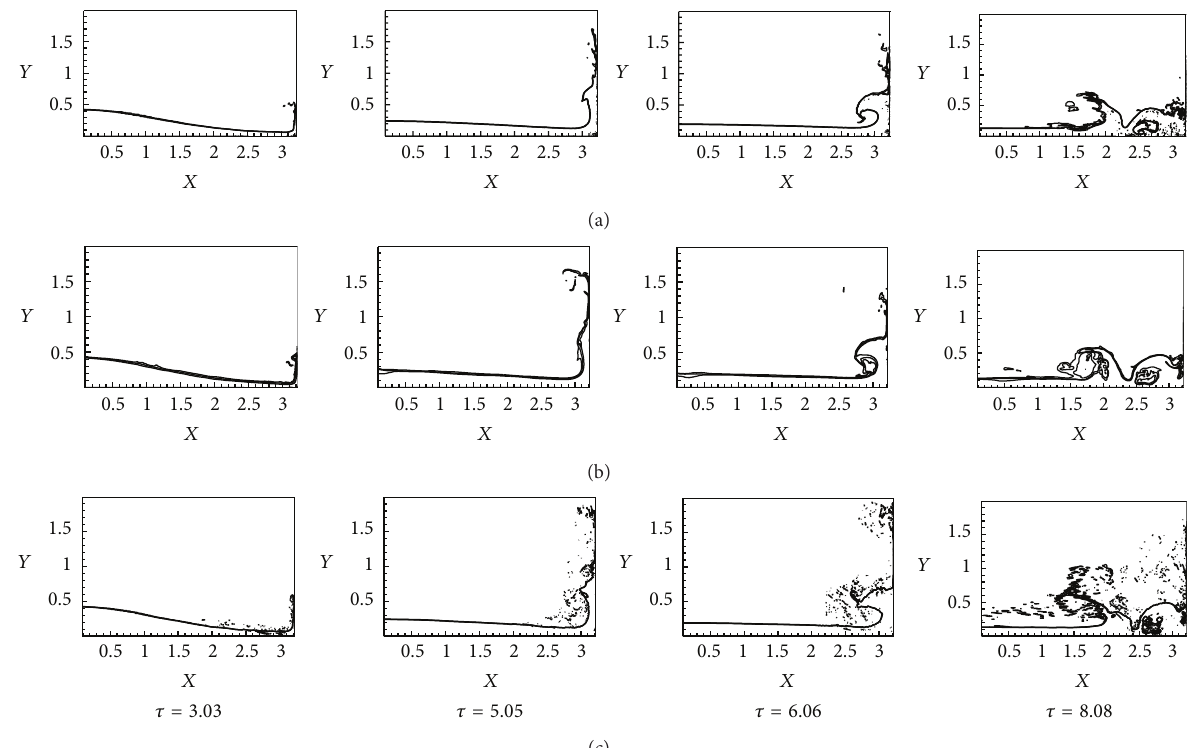
Figure 9: Comparisons of density function contours. The three lines indicate that 𝜑 = 0.05 , 0.50, 0.95. The interface-capturing scheme is THINC in (a), CIP in (b), and VOF in (c).